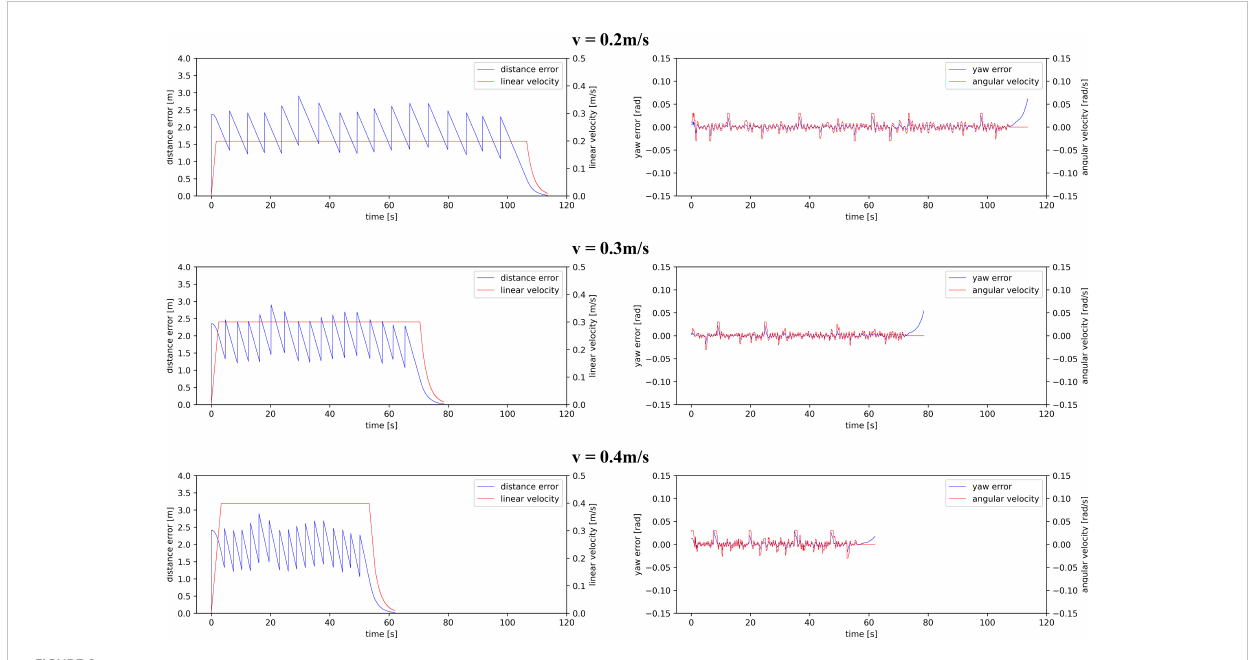
FIGURE 9 The performance of distance and heading controller at various MRP speeds.